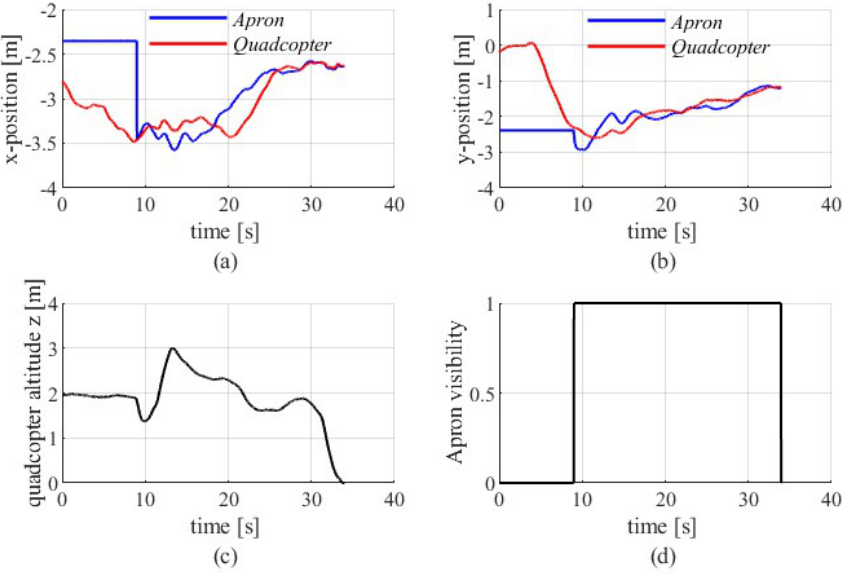
Figure 7. Landing target approaching control performance, including ( a , b ) the positions and ( c ) the altitude of the quadcopter and ( d ) the visibility of the